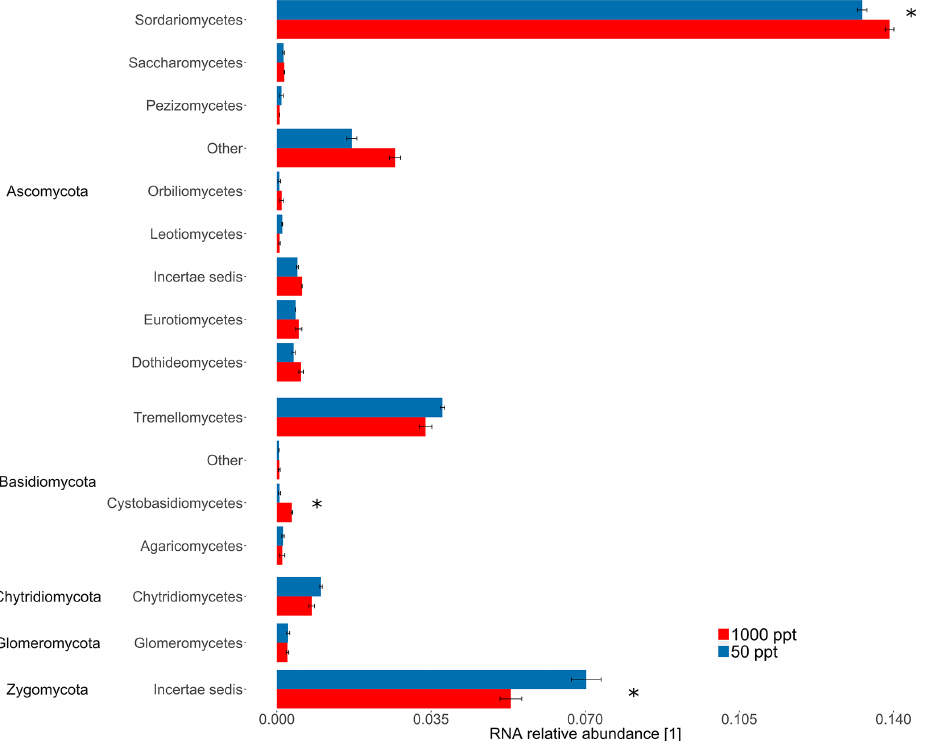
Figure 4. Taxonomic composition of the midlatitude corn field soil in Mainz, Germany, at 22% WFPS lab of the samples under 1000 or 50pptOCS. RNA relative abundance of internal transcribed spacer (ITS) for fungal classes was normalized by the total number of assigned reads per sample. Classes with RNA relative abundance < 5 × 10 − 4 did not show significant differences and were not plotted. Error bars represent standard deviation. Asterisks represent statistically different values ( p value < 0.05). “Other” is identified by the QIIME pipeline, however with no known classification in the database, under the used threshold of sequence similarity (90%).